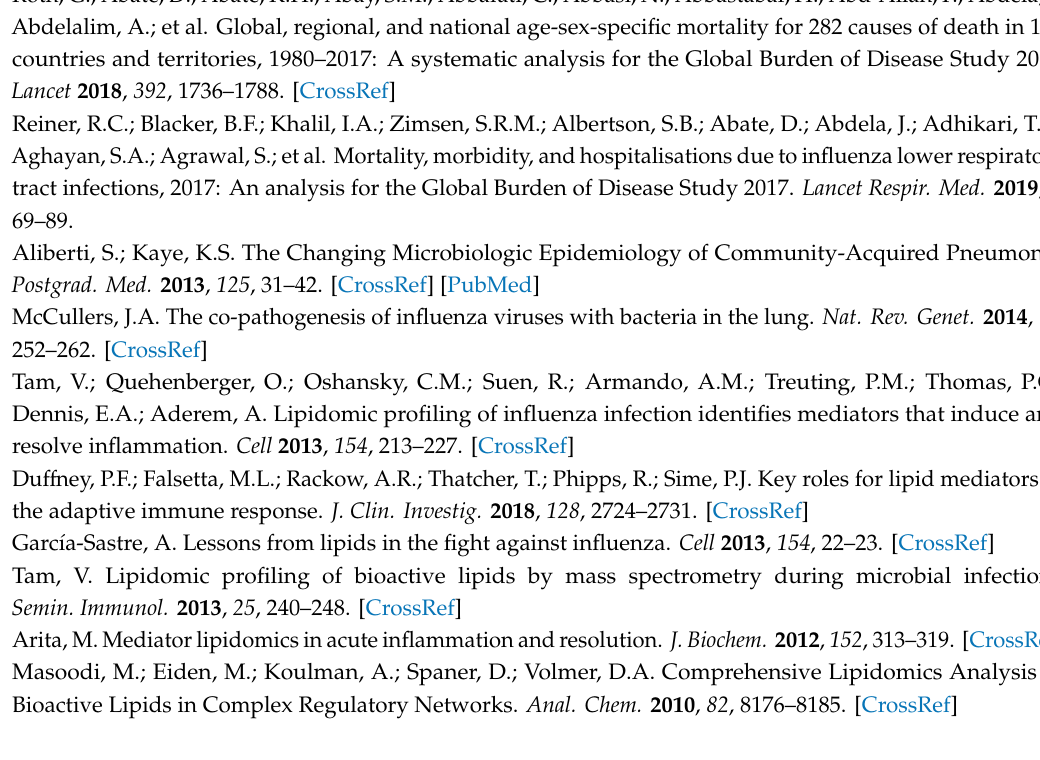
raw data. Figure S1: Survival rate of 16HBE cells under indicated infection conditions; 16HBE cells were infected as described in the Materials and Methods section; 6 h post bacterial infections, the vital cells were detached and counted; cell counts were normalized to the uninfected controls and are displayed as percentage of the uninfected control. Figure S2: Heatmap displaying fold changes (infection / control) of measured lipid mediators; decreased levels are shown in green and increased amounts in red. Table S1: Optimized MRM parameters for analyzed lipid mediators with qualifier 1 and quantifier 2 ion; grey lipid mediators were not detected. Table S2: Calculated p -values from Mann–Whitney test. Table S3: Spearman´s range